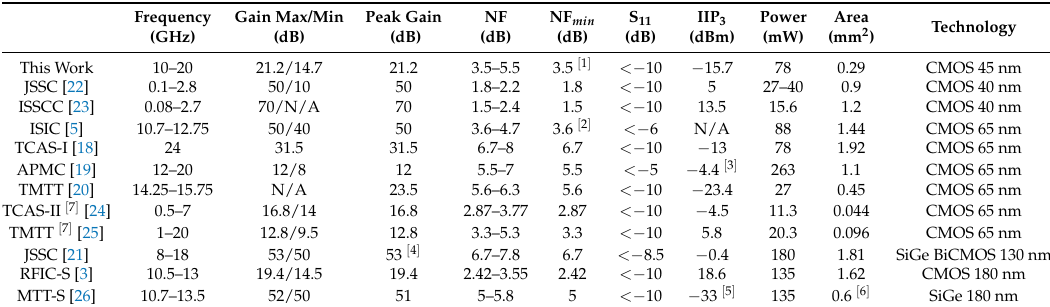
Table 3. Performance summary and